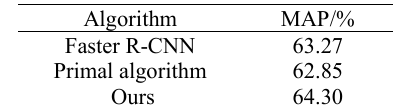
Table 1 . Algorithm detection results.